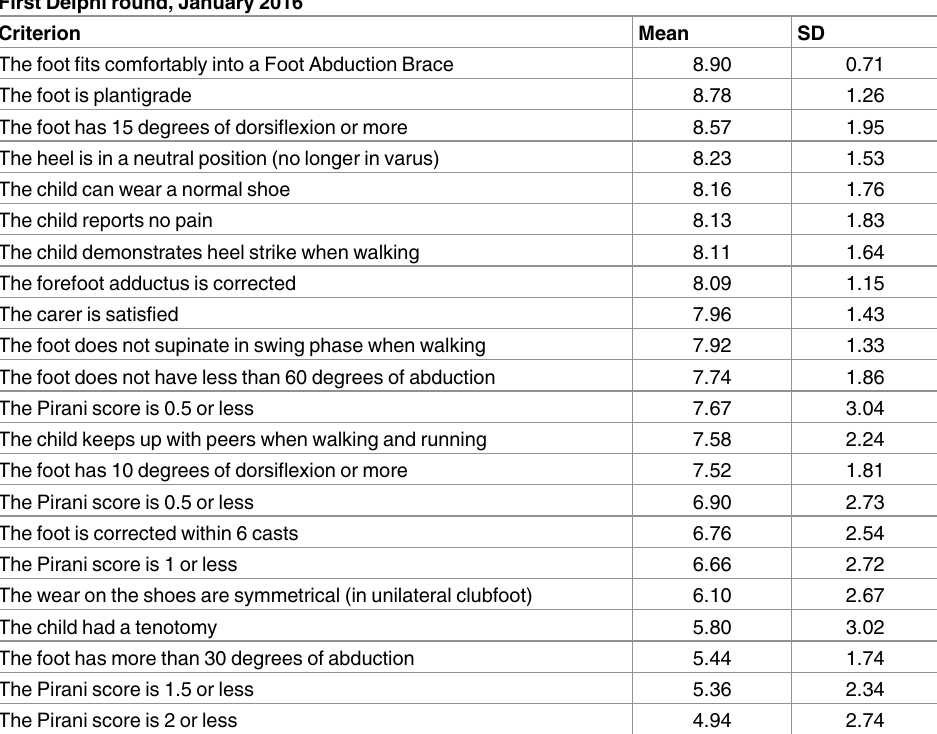
Table 1. Final rating of criteria in the first Delphi round (ordered by visual analogue scale mean and standard deviation). First Delphi round, January 2016 Criterion